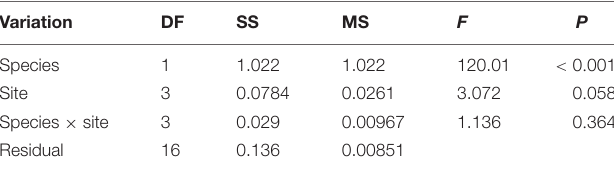
TABLE 1 | Results of analysis of variance (ANOVA) to test the effect of coral species, site, and coral species: site on microfiber abundance in corals. Variation DF SS